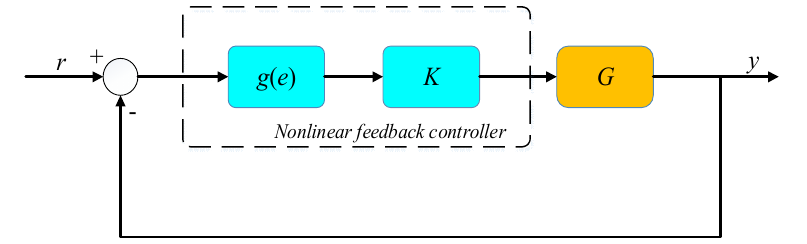
Figure 1. Diagram of nonlinear feedback control.